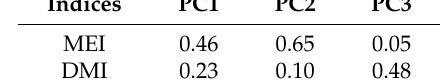
Table 2. Correlations of the first three principal components (PC1, PC2 and PC3) with MEI and DMI.